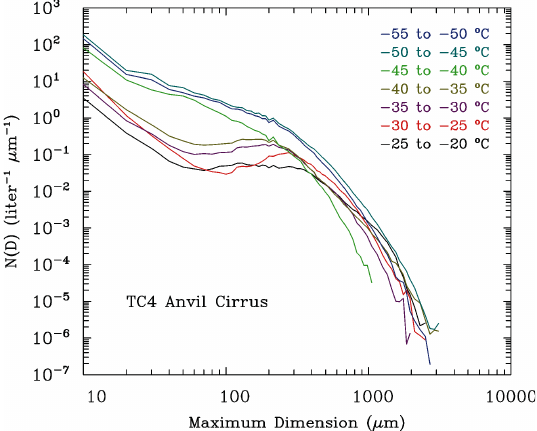
Fig. 11. Mean PSD (averaged over intervals of 5 ◦ C) from “fresh” anvil cirrus sampled during TC4.